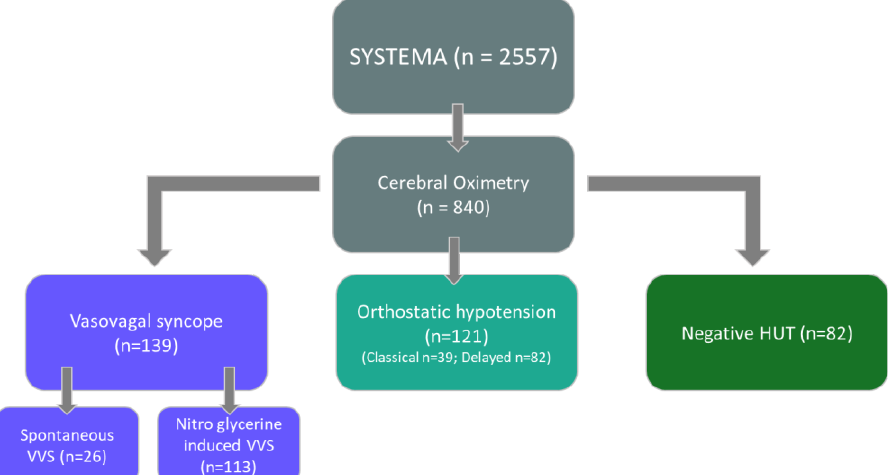
Figure 1. Study population flow chart. Abbreviations: HUT = head-up tilt test; SYSTEMA = syncope study of unselected population in Malmö; VVS = vasovagal syncope.